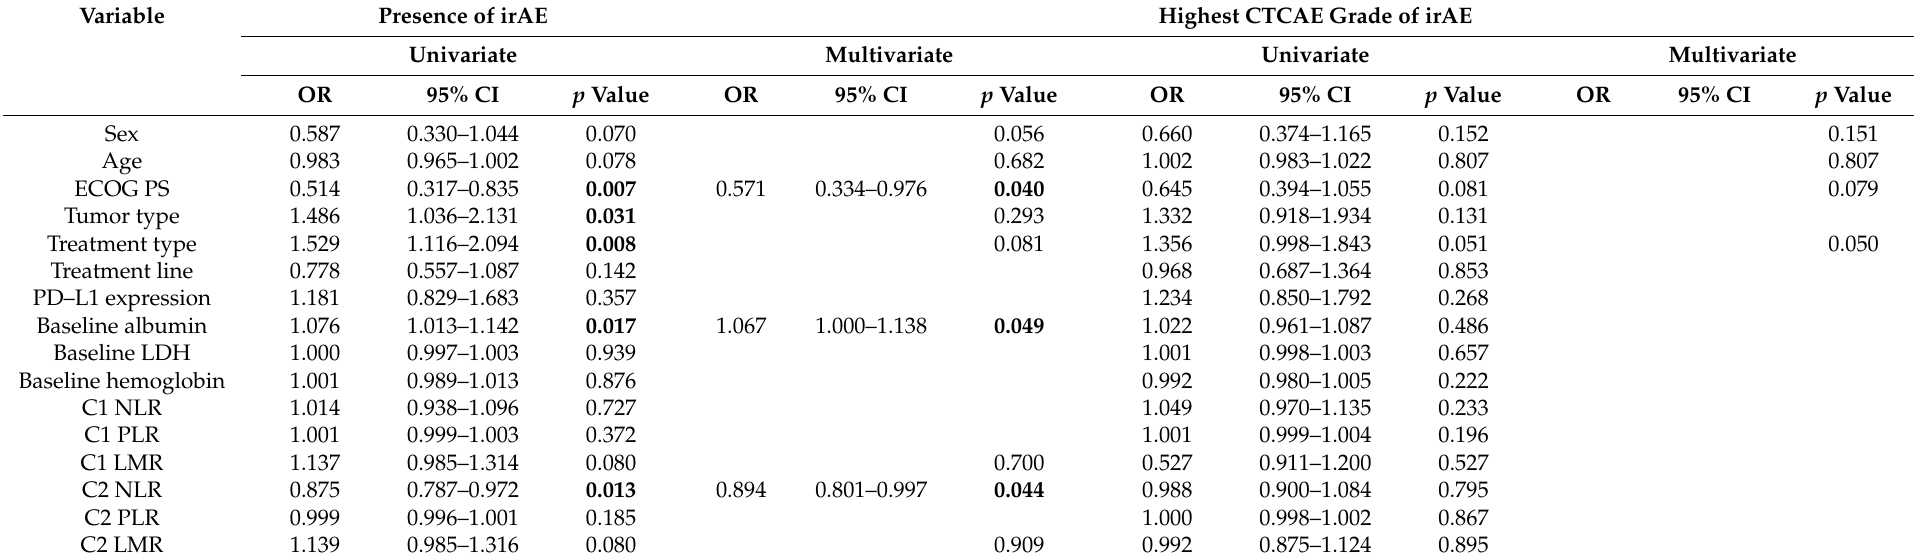
Table 4. Univariate and multivariate analyses of